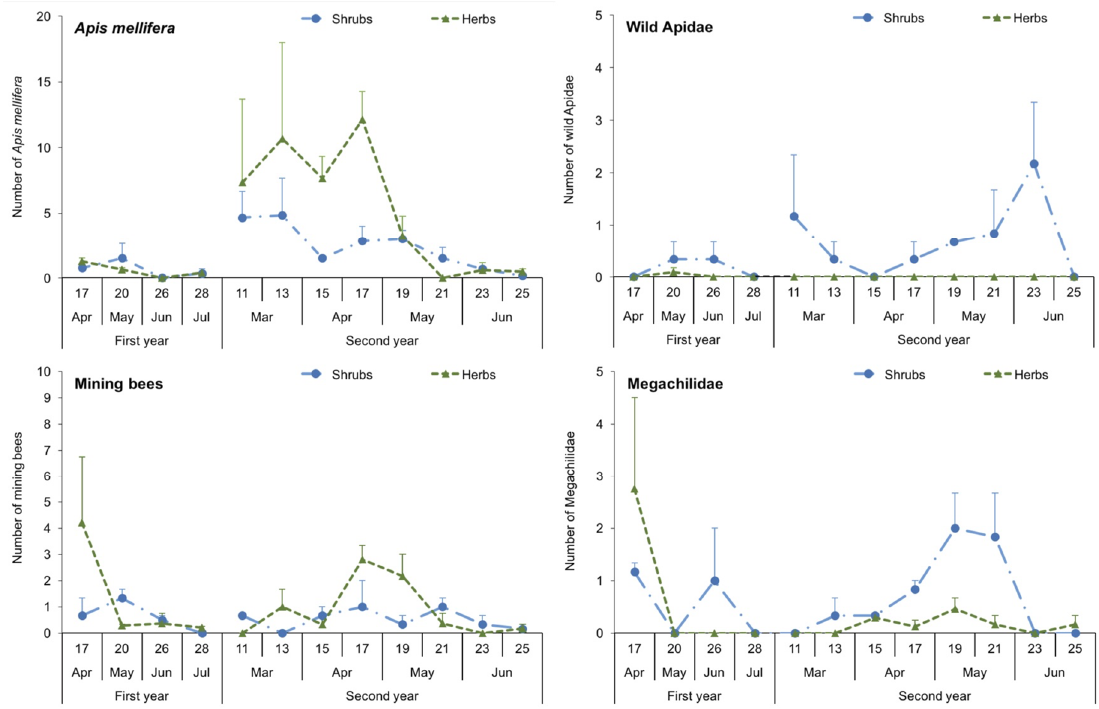
Figure 3. Visual sampling. Numbers of A. mellifera , wild Apidae, mining bees and Megachilidae observed in 2 × 2 m squares over a four-minute period in shrubby, herbaceous and control margins (means ± SE). The numbers in the abscise (x) axe indicate the week of the year.